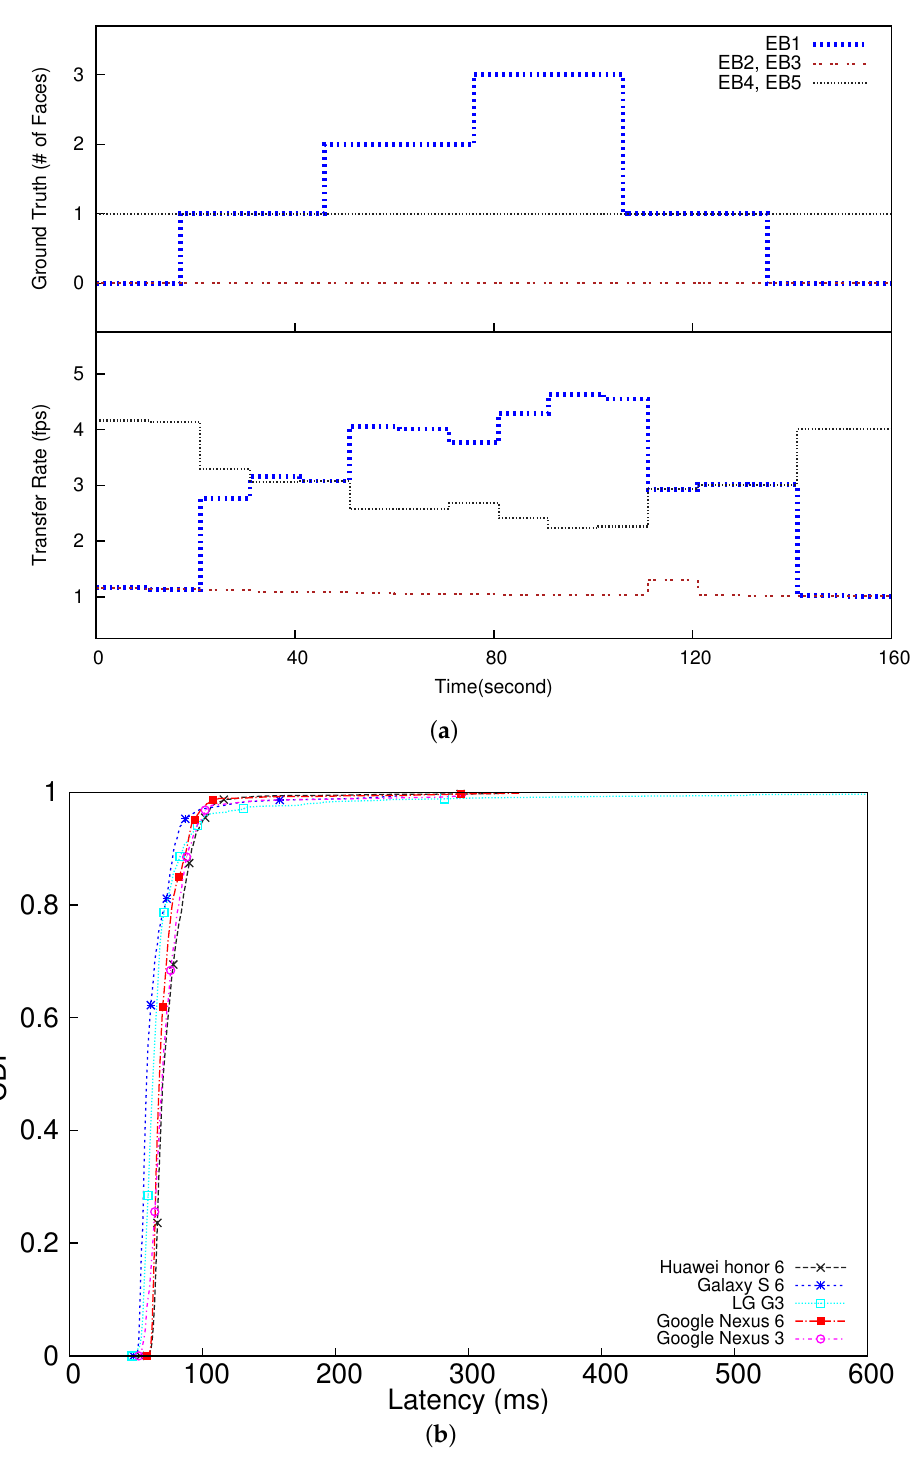
Figure 7. Case Study ( R = 12 fps, r min = 1 fps, r max = 5 fps). ( a ) Frame rate changes according to the ground truth (the actual number of faces); ( b ) CDF of End-to-End